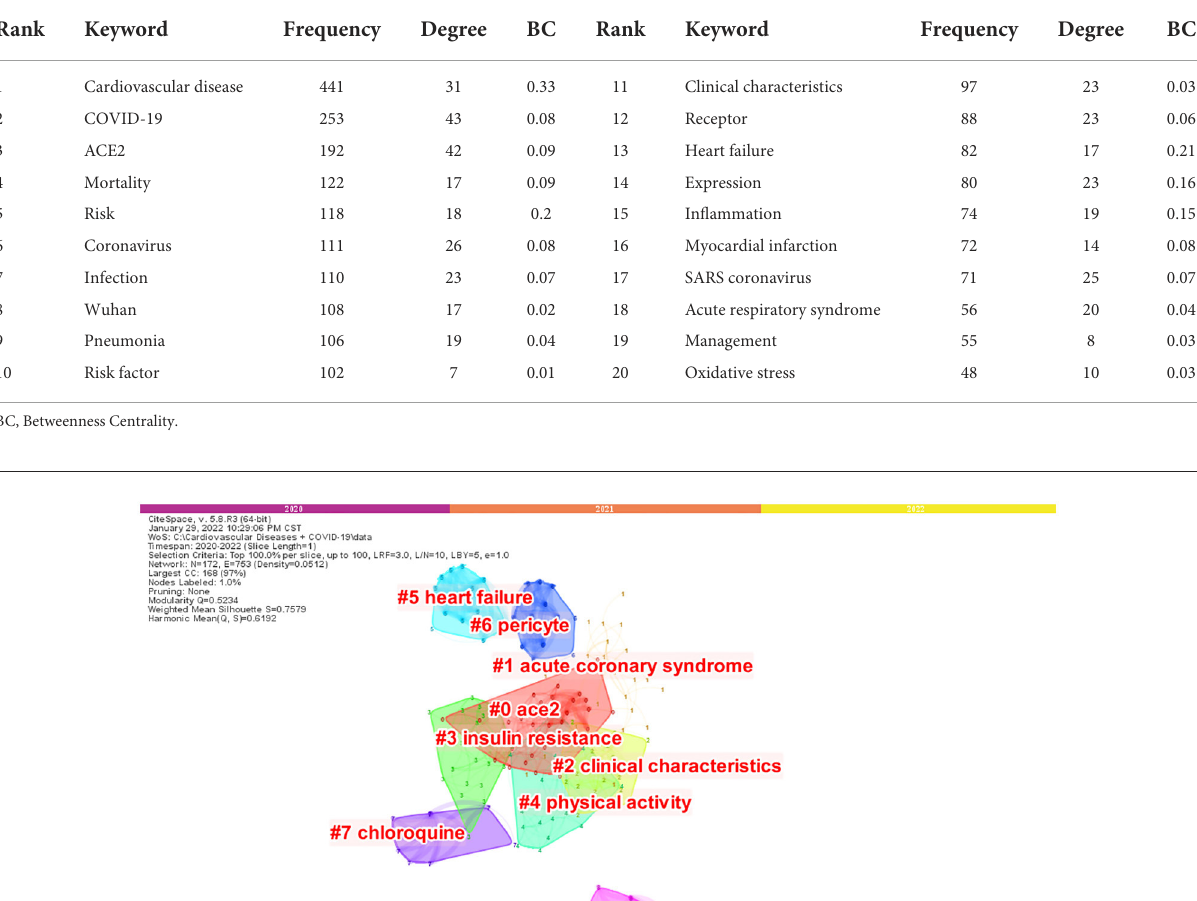
TABLE 6 Top 20 keywords related to CVDs and COVID-19 research.